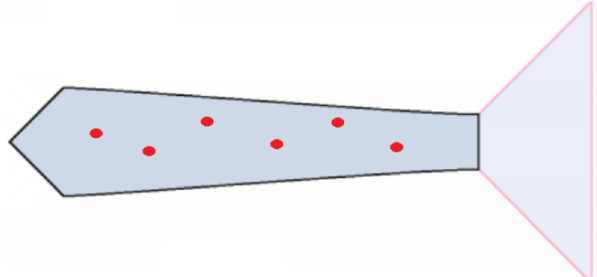
Figure 25 . A one-sided black hole is allowed to evaporate, and then the Hawking radiation is measured. This produces a pure black hole microstate with interior modes that are in some simple state that depends on the measurement outcome. In the maximal volume slice, there is a local minimum of the generalized entropy near the horizon, where the area is